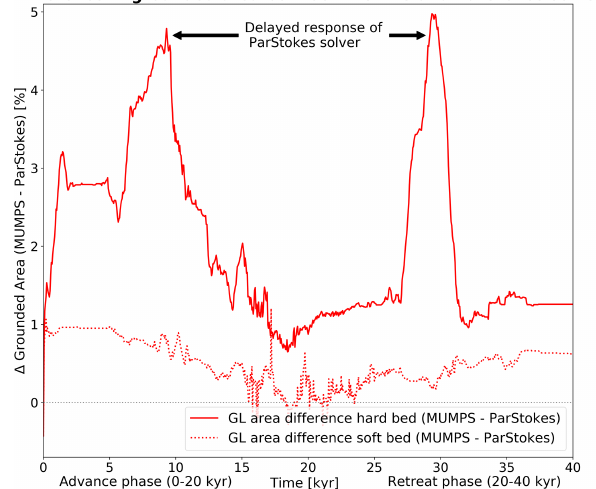
Figure 5. Differences in grounded area between the classic MUMPS and ParStokes solver setup for the soft-bed and hard-bed